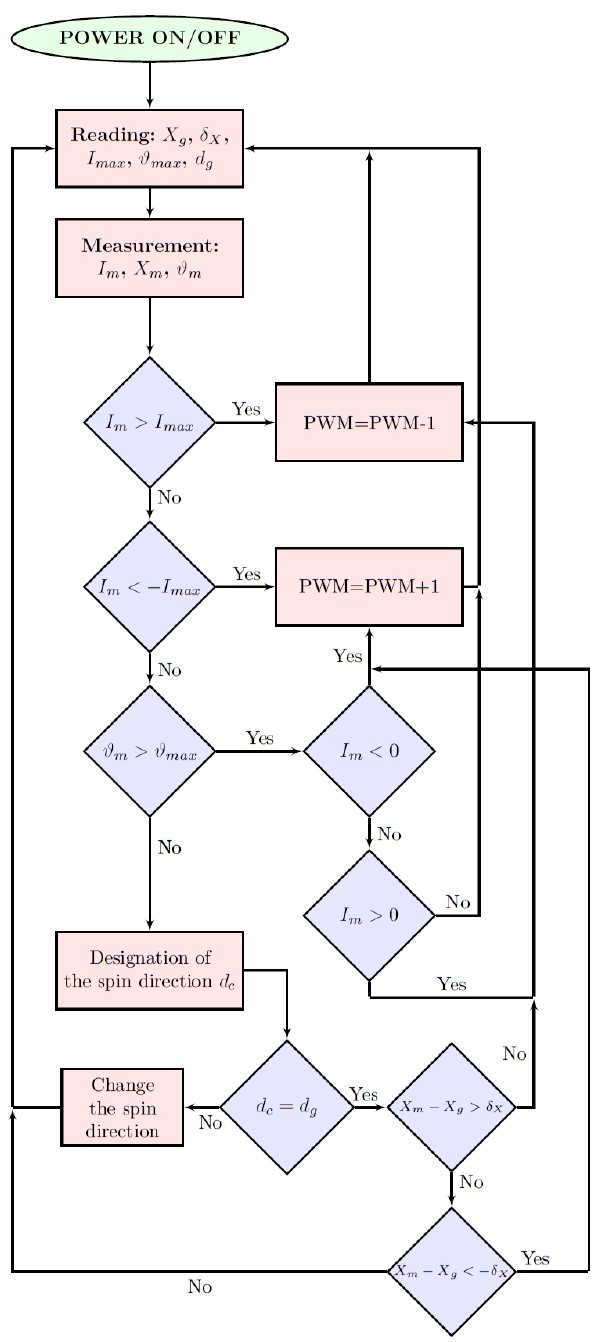
Figure 23. Block diagram of the microcontroller program which stabilizes the speed or the set mechanical torque X with current and temperature